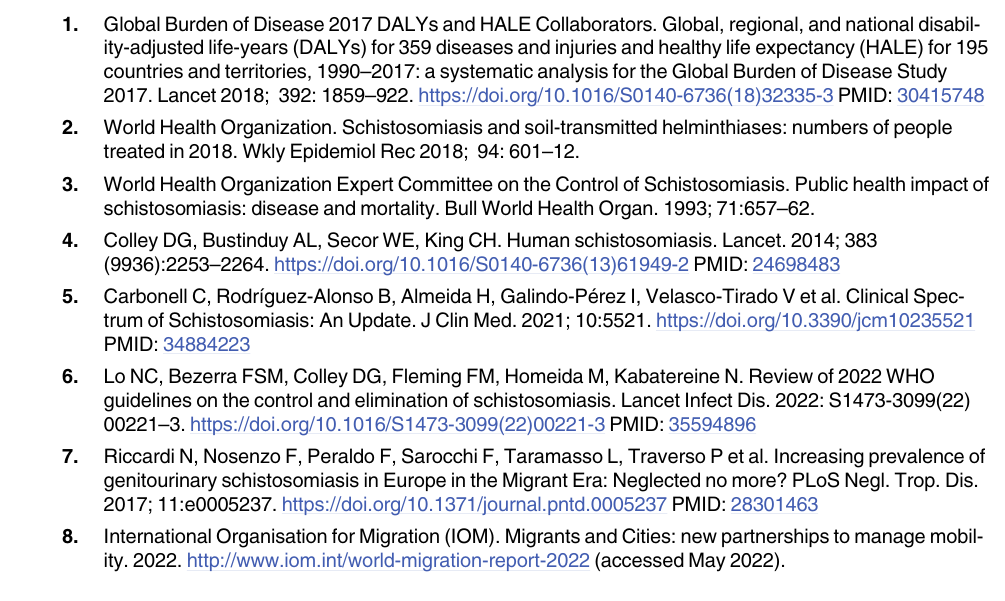
S1 Data. Dynamic table of schistosomiasis screening